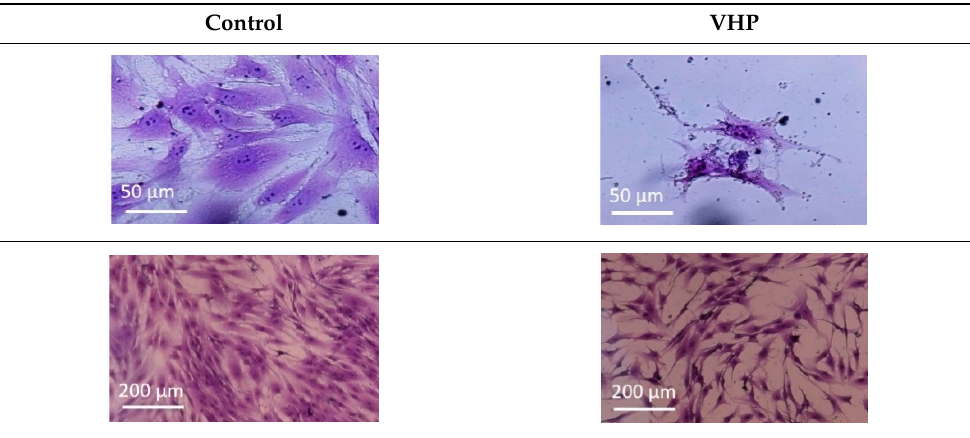
Table 4. Comparative images of the cultures 24 h post-treatment.